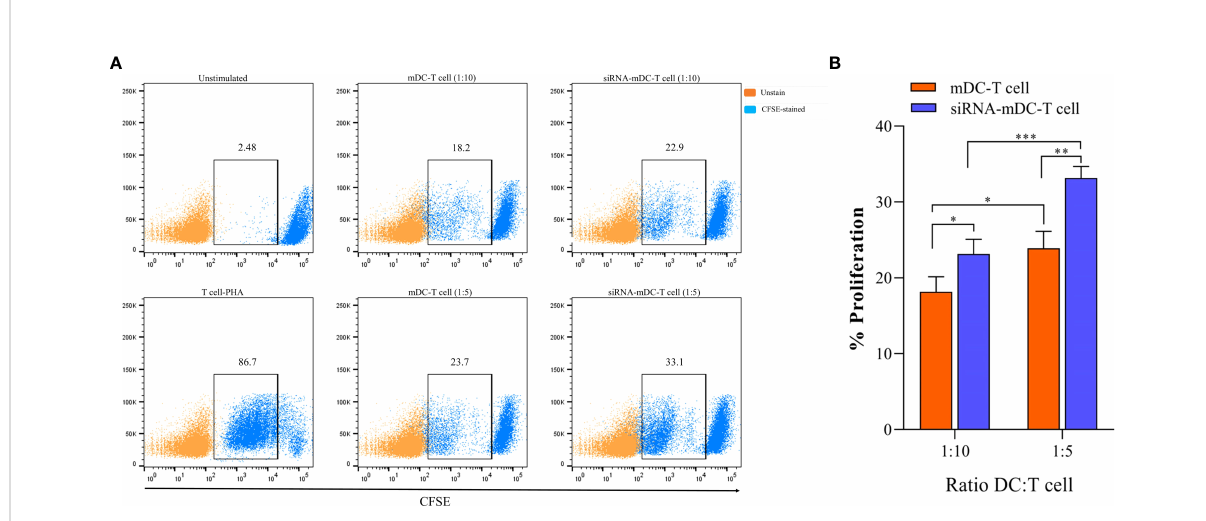
FIGURE 4 CTLA-4-silenced-mDCs signi fi cantly increase CD3+ T cells ’ proliferation. (A) The percentage of CFSE-labeled autologous CD3 + T cells provoked by mDCs and CTLA-4-silenced-mDCs at a 1:5 and 1:10 DC/T cell ratio were determined by FACS via calculating the CFSE loss. (B) Enhanced mDC ’ s capacity in T cell proliferation following CTLA-4 knockdown; (*P ≤ 0.05, **P ≤ 0.01, and ***P ≤ 0.001). CTLA-4, Cytotoxic T- lymphocyte-associated protein-4; mDCs, Tumor cell lysate-loaded mature dendritic cells; siRNA-mDCs, CTLA-4-silenced mDCs; FACS, Fluorescent activated cell